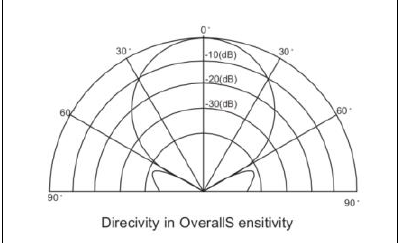
Fig. 5. Directivity for transmitters/ receivers MCUST/R.